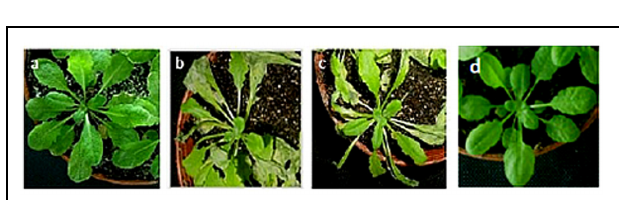
FIGURE 2 | Progression of disease symptoms caused by U. virens infection. The disease symptoms in Arabidopsis ecotype, Col-0: (a) 0 dpi; (b) 3 dpi; (c) 6 dpi; (d)